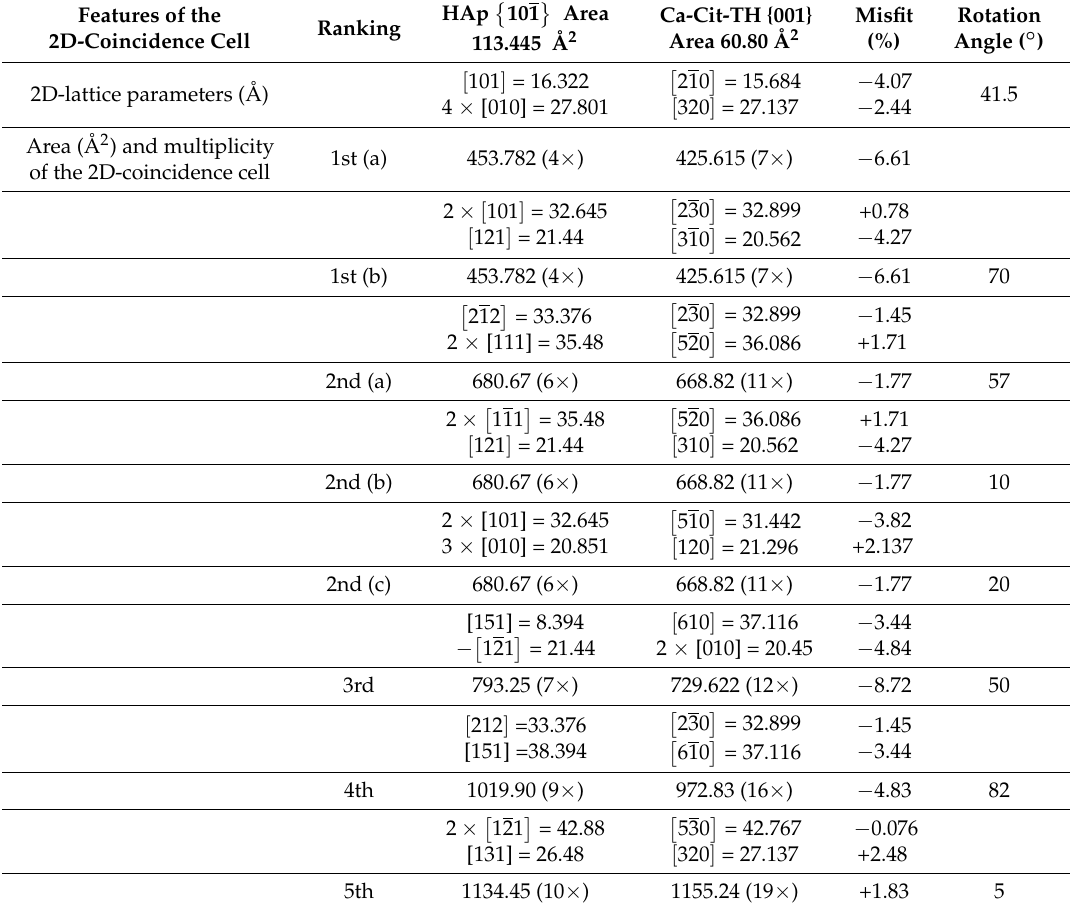
Table 4. 2D-coincidence lattices between the Rotation angle refers to the angle formed between the vectors [010] HAp and the vector [100] Ca-Cit-TH . Features of